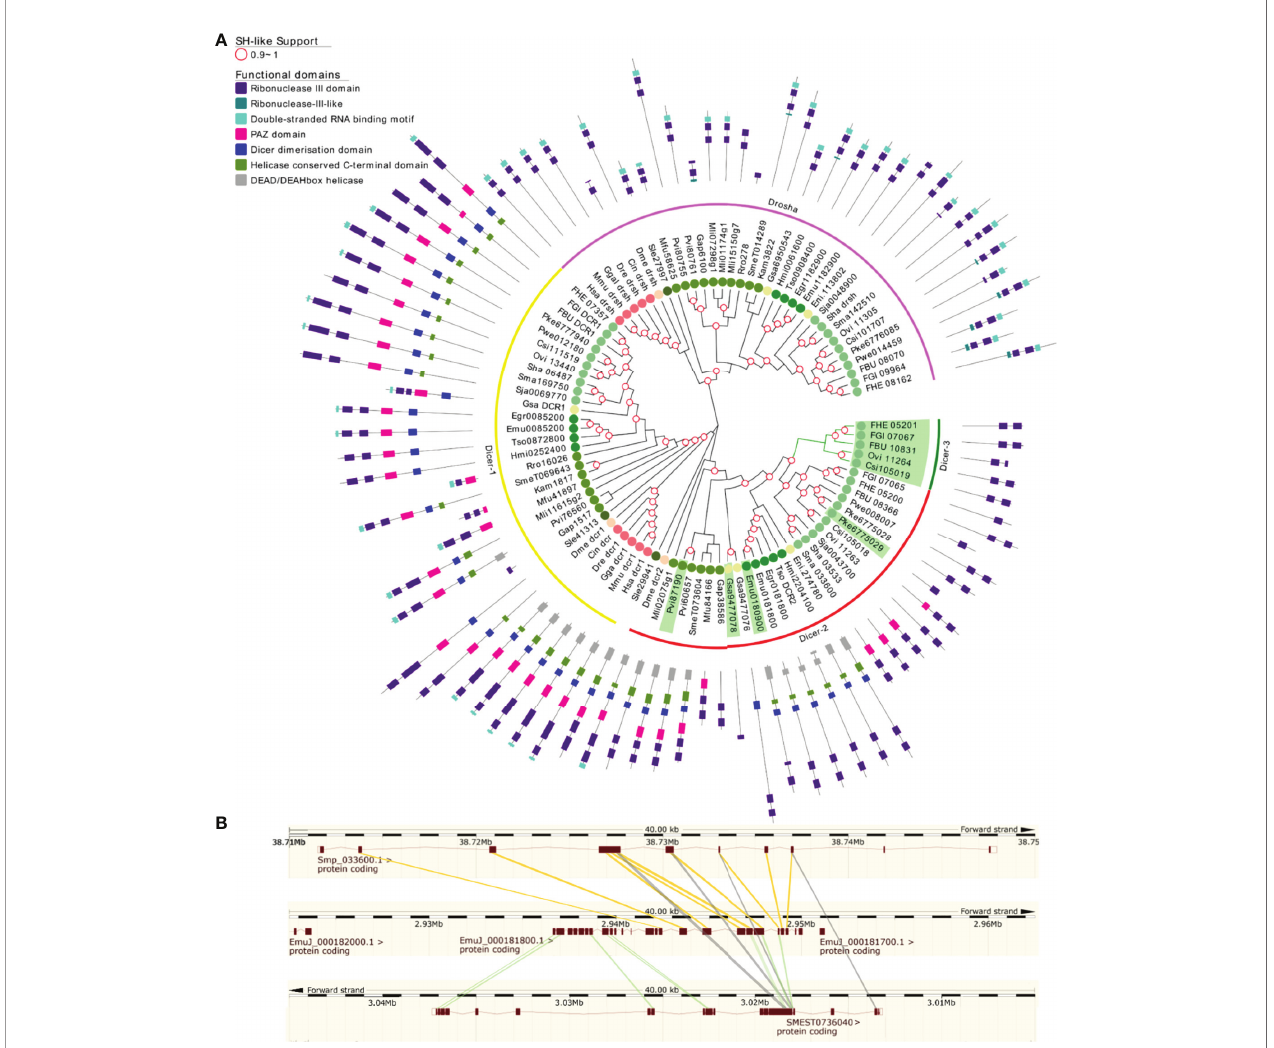
FIGURE 6 | Ribonuclease III subfamilies of fl atworms (A) A maximum likelihood tree of Ribonuclease III subfamilies. SH-like approximate likelihood ratios are indicated. Conserved protein domains were predicted with HMMScan. Dcr -2 (red arch) duplications are highlighted in green. Dcr-2 is ancestrally duplicated in FBT (dicer-3, green arch). Dcr-2 has missing domains in trematodes compared to cestodes, similar structural heterogeneity was observed between ‘ turbellarians ’ . Abbreviations are as indicated in Figure 2 . (B) High scoring pairs between Dcr-2 genes of S. mansoni , E. multilocularis and S. mediterranea